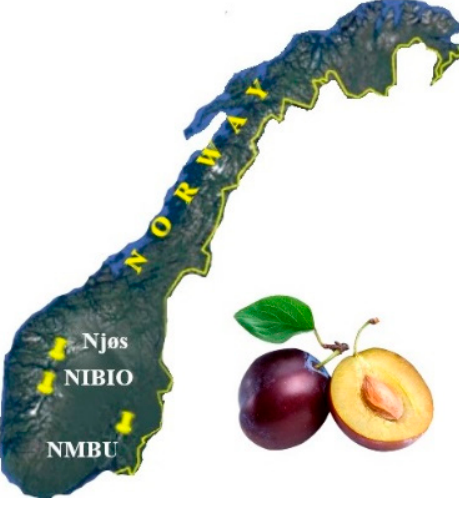
Figure 1. Sampling sites of plum cultivars grown in Norway: The experimental farm at Njøs Fruit and Berry Centre-Njøs, Norwegian Institute of Bioeconomy Research-NIBIO Ullensvang, The Norwegian University of Life Sciences-NMBU.